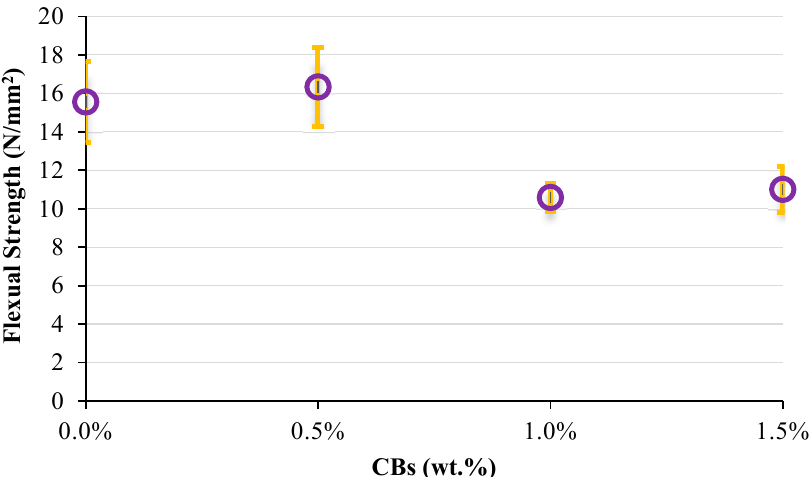
Figure 7. Breaking strength versus CB% by mass.